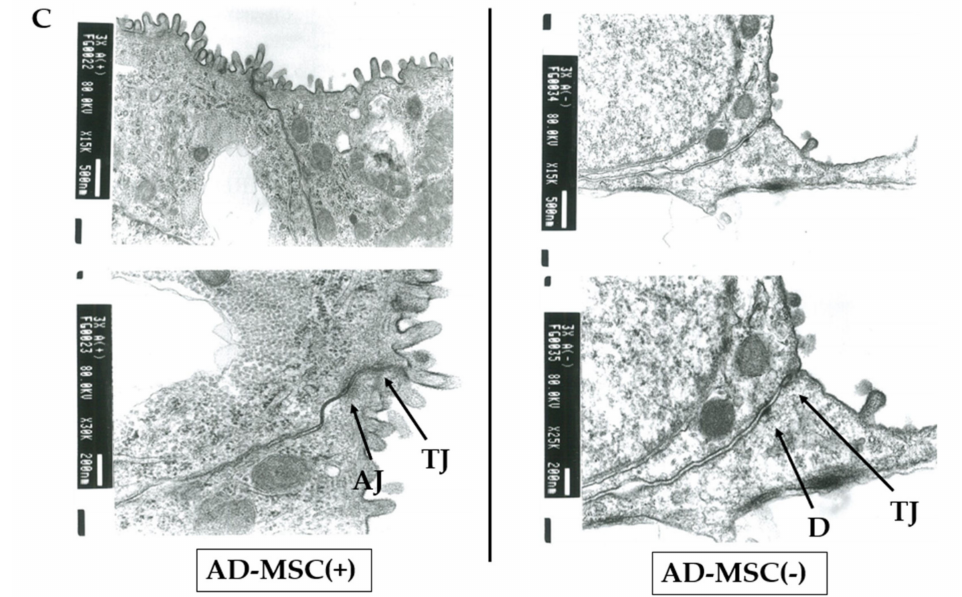
Figure 6. Immunostaining and transmission electron microscopy of cell junctions. ( A ) Immunos- taining of lung cells seeded in insert membranes on day 4 (ZO-1). ( B ) Immunostaining of AT2 cells seeded in insert membranes on day 7 (ZO-1). ( C ) Transmission electron microscopy of ATII cells on day 7 after seeded on insert membranes and cultivation with (+) or without ( − ) non-contact AD-MSCs. TJ, tight junction; AJ, adherens junction; D, desmosome.